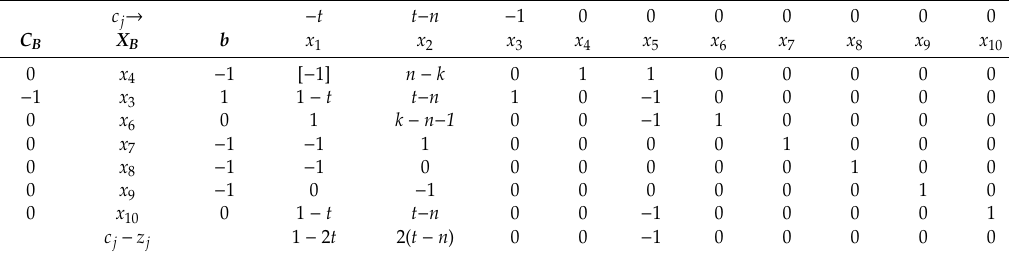
Table 2. Simplex table of IPM I for Case 1 after one iteration.